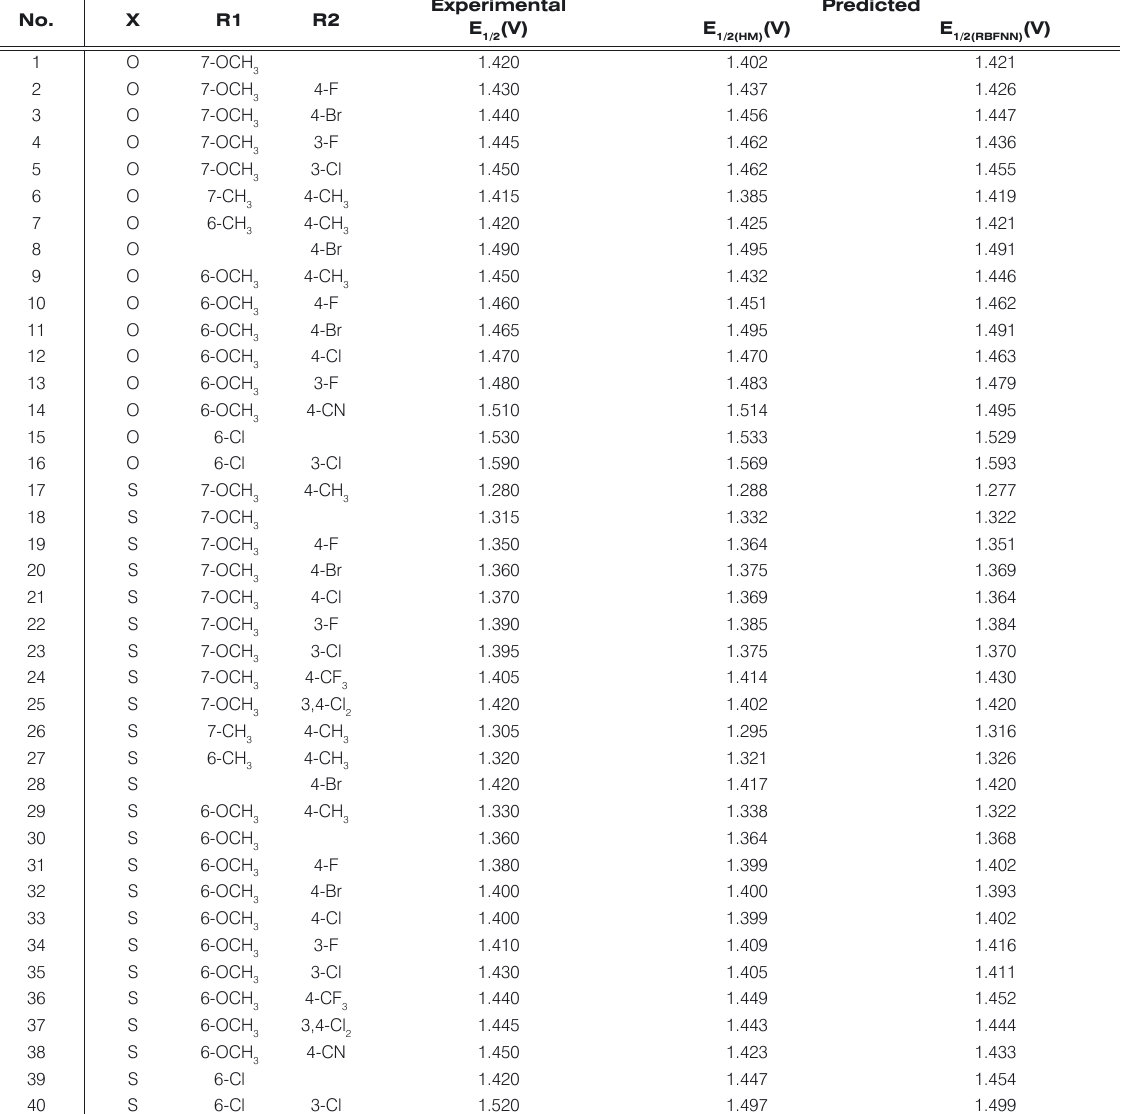
for the compounds 1/2